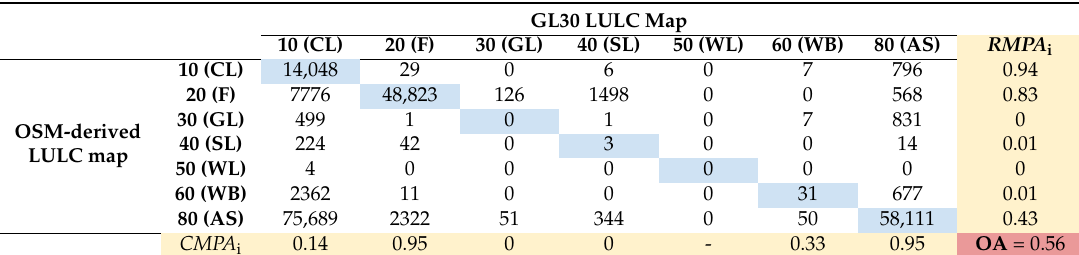
Table 5. Confusion matrix and indices of agreement for the Kathmandu study area: row marginal proportion of agreement (RMPA), column marginal proportion of agreement (CMPA) and overall agreement (OA).